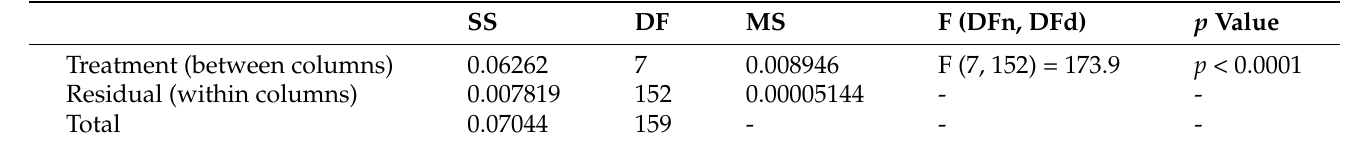
Table 7. Presented bGSDTO versus compared algorithms ANOVA test results.